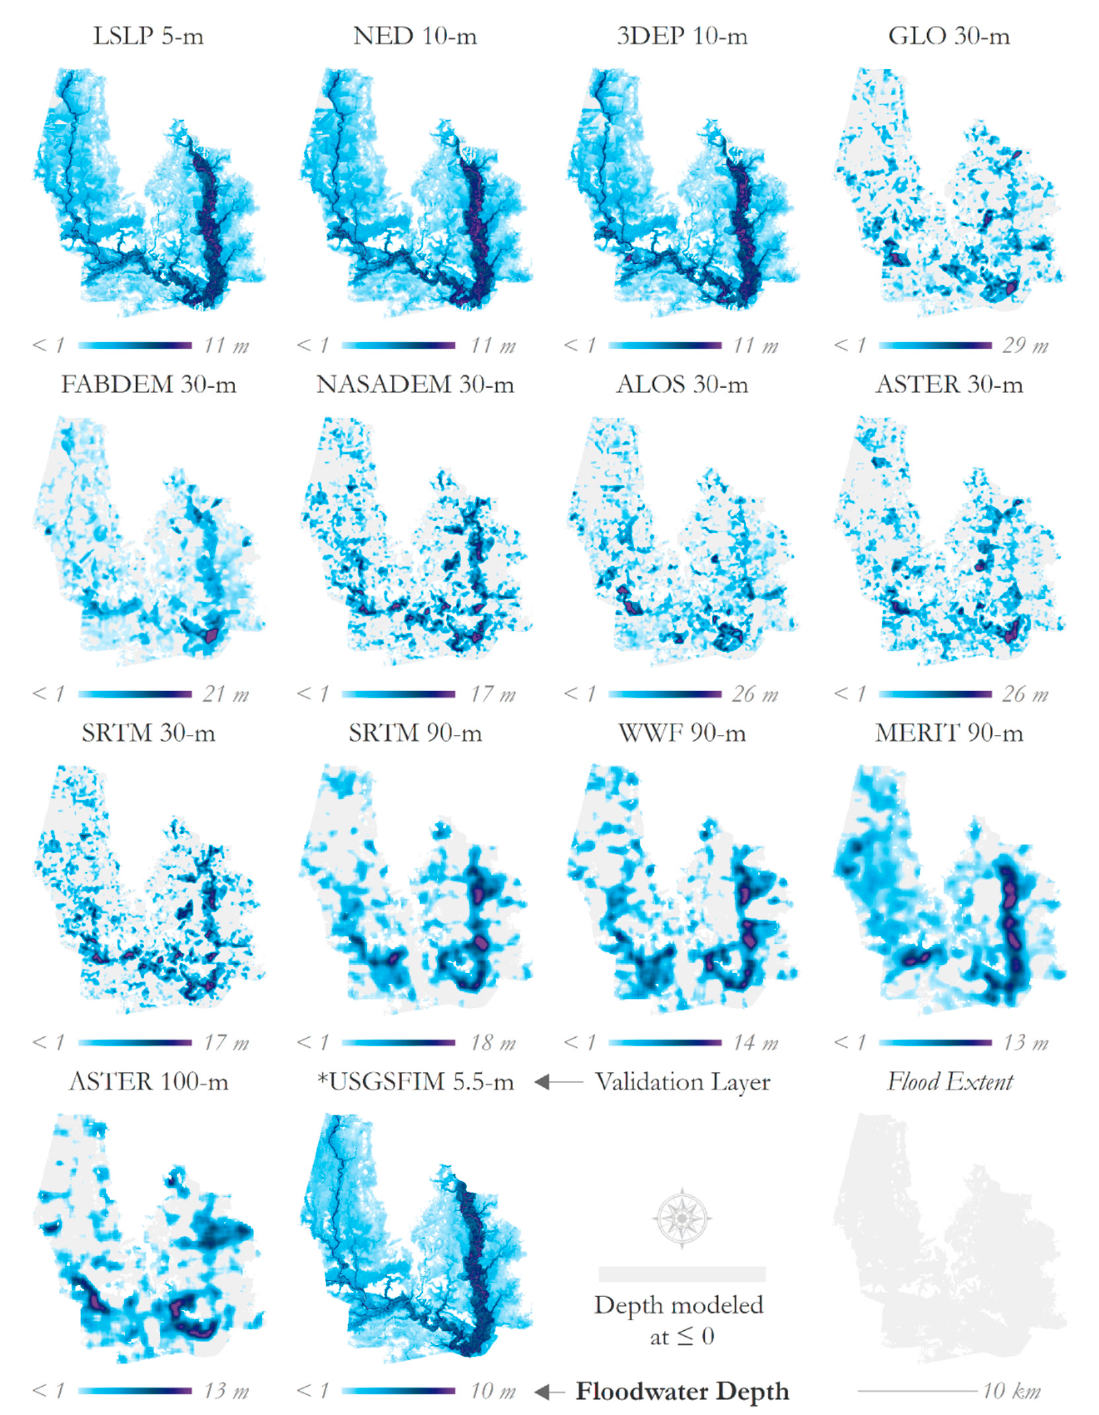
Figure 4. FwDET-GEE outputs resulting from DEMs of varying spatial resolutions (5–100 m). The areas depicted in gray were modeled at ≤ 0 m depth. *The USGS FIM hydraulic model reference areas depicted in gray were modeled at ≤ 0 m depth. * The USGS FIM hydraulic model reference map.